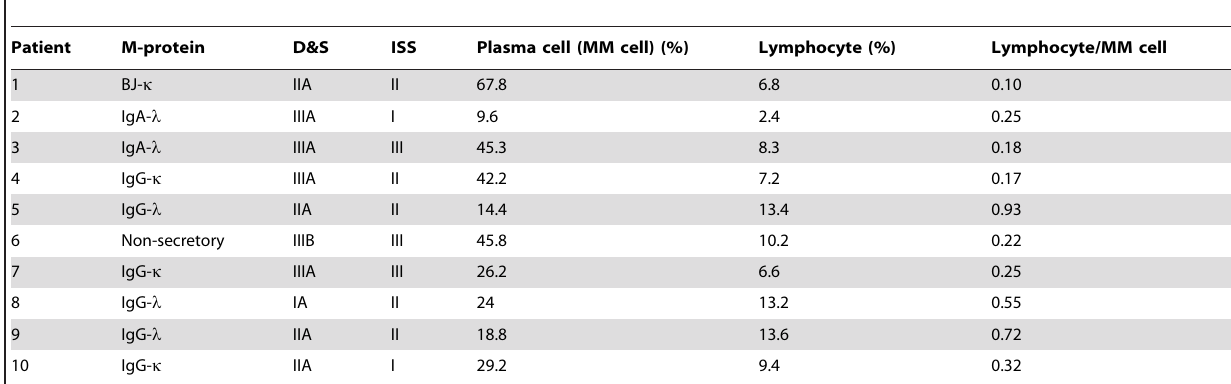
Table 1. The characteristics of BMMCs from patients with